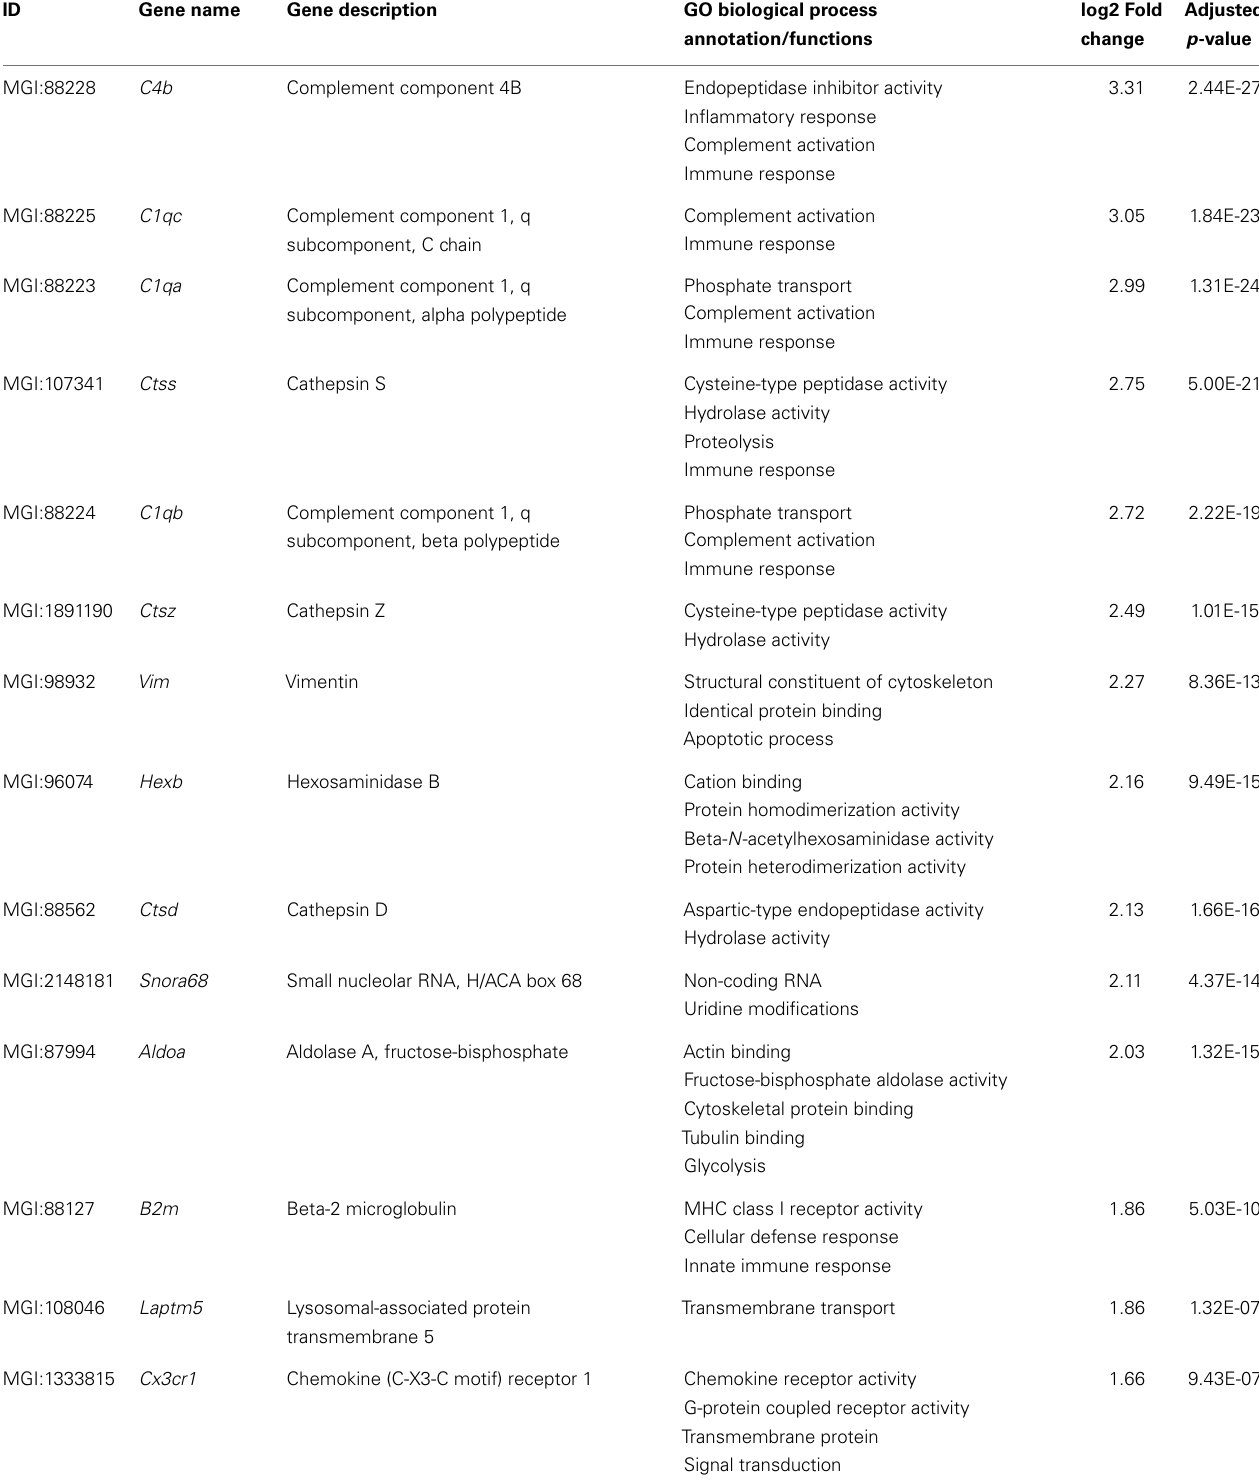
Table 5 | List of differentially expressed transcripts in aged 5XFAD